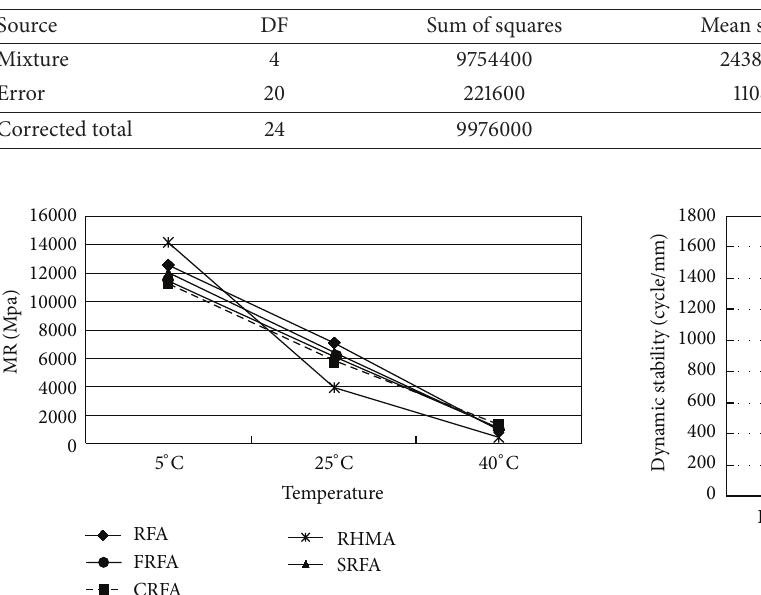
Table 4: Analysis of variable result for Marshall stability.